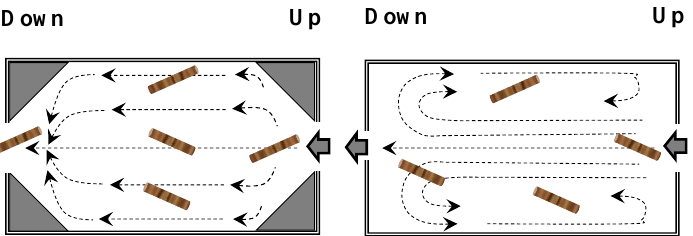
Figure 18. Effect of different basin shape/configuration (corner installation) on the flow conditions and capture function of the basin. ( Left : with corners; right : without corners).